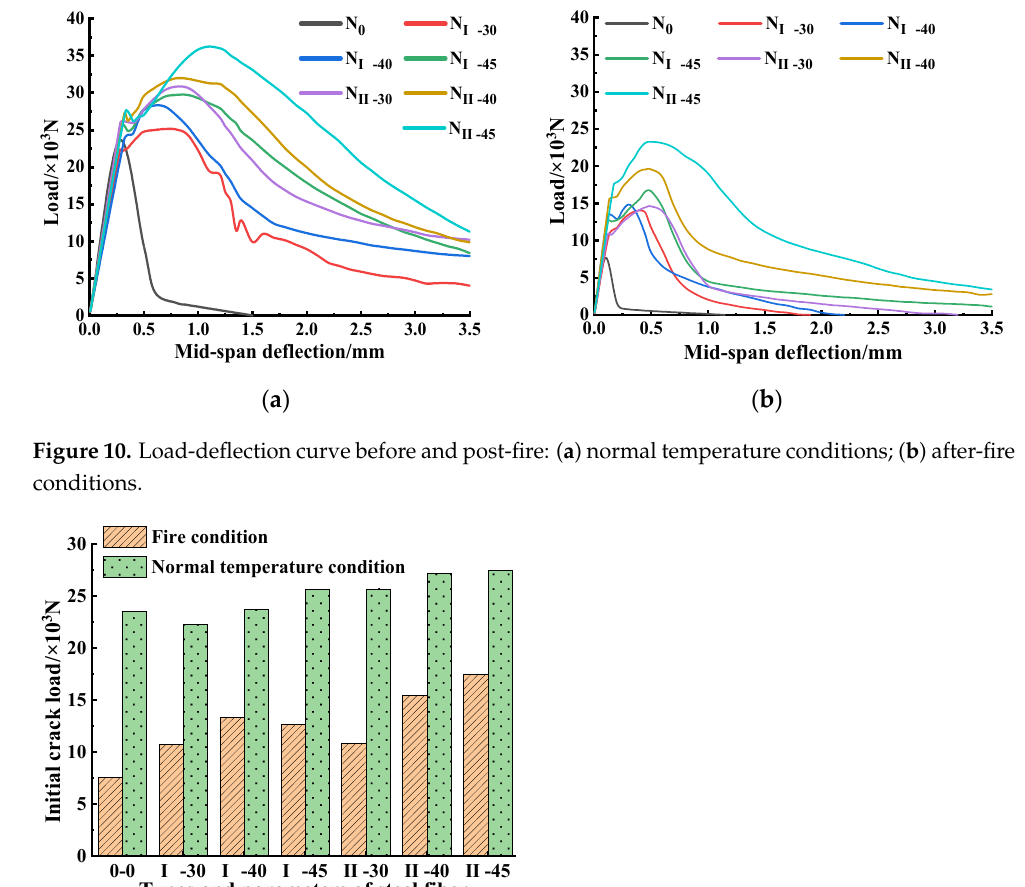
Table 7. Calculation results of the mechanical properties of SFRC before fire. Specimens